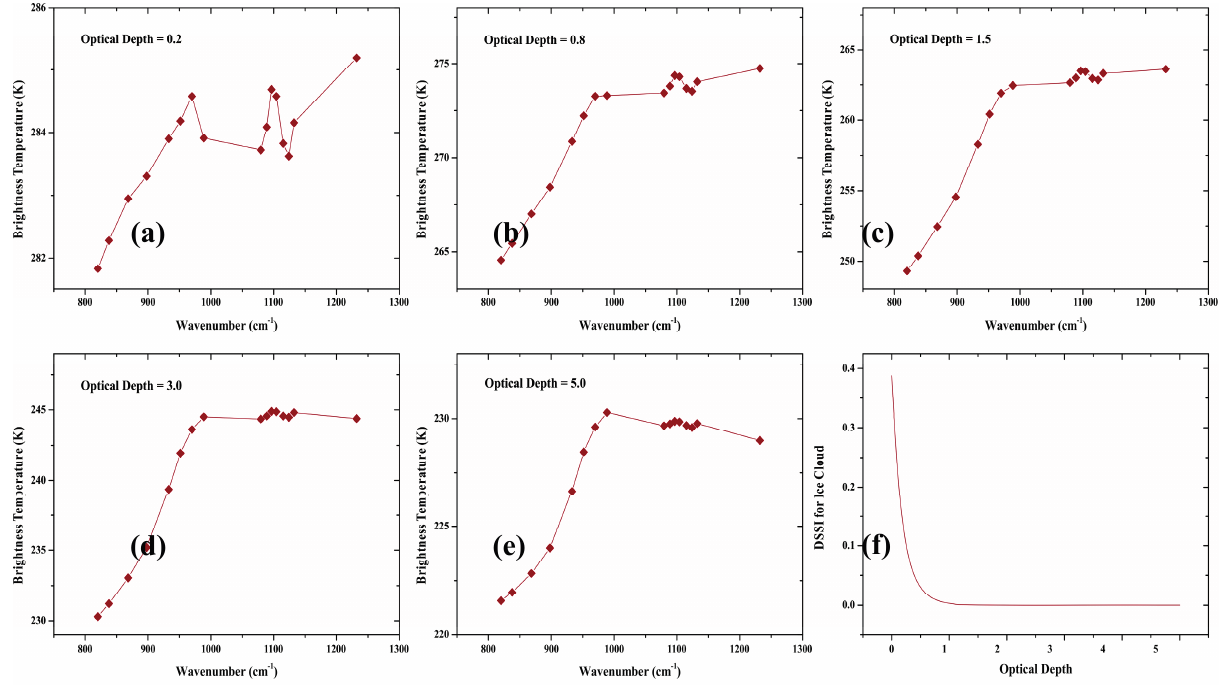
Figure 4. ( a–e ) The simulated nadir-viewed spectral brightness temperatures of selected AIRS channels for five different ice cloud optical depths (0.2, 0.8, 1.5, 3.0 and 5.0). ( f ) The variation trend of DSSI under the condition of ice cloud.